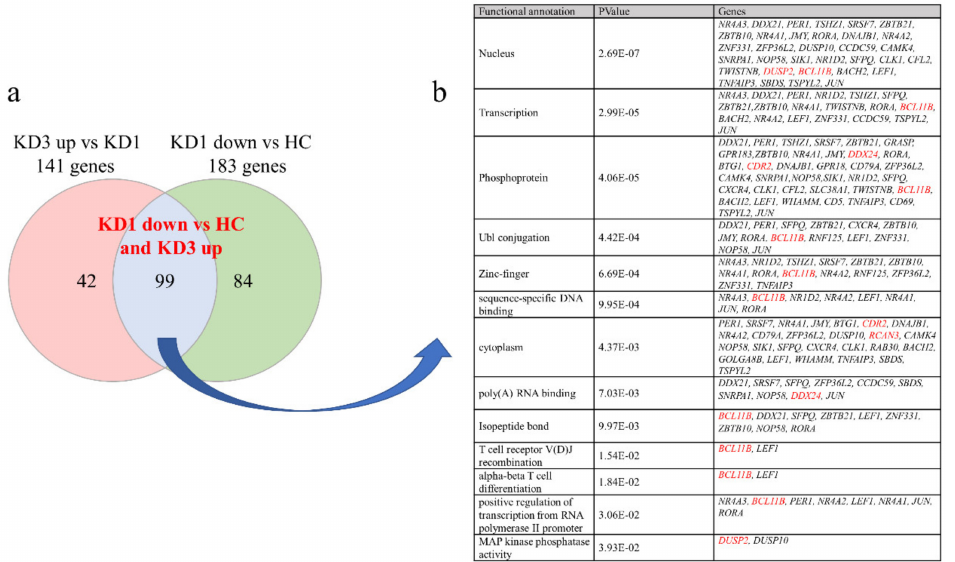
Figure 1. Patients with acute-stage KD have less suppressed than increased genes compared to controls as determined by HTA 2.0. ( a ) Putative differentiated gene targets between Kawasaki disease (KD) and controls were screened by Targetscan7.2. A Venn diagram illustrates numbers between groups; ( b ) A KEGG pathway analysis of 99 putative target genes in humans. In addition, we observed that BCL11B, DUSP2, DDX24, and CDR2 demonstrated the most significant fold-changes between KD patients (KD1) before IVIG and 3 weeks after IVIG administration (KD3). Note that BCL11B, DUSP2, DDX24, and CDR2 (highlighted in red) are present in all the pathways.